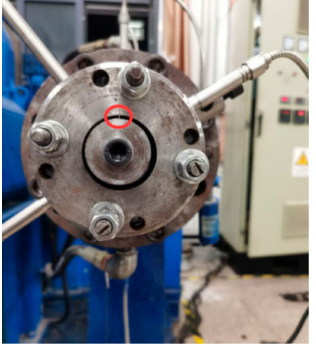
Figure 7. Image of the radial-orientation